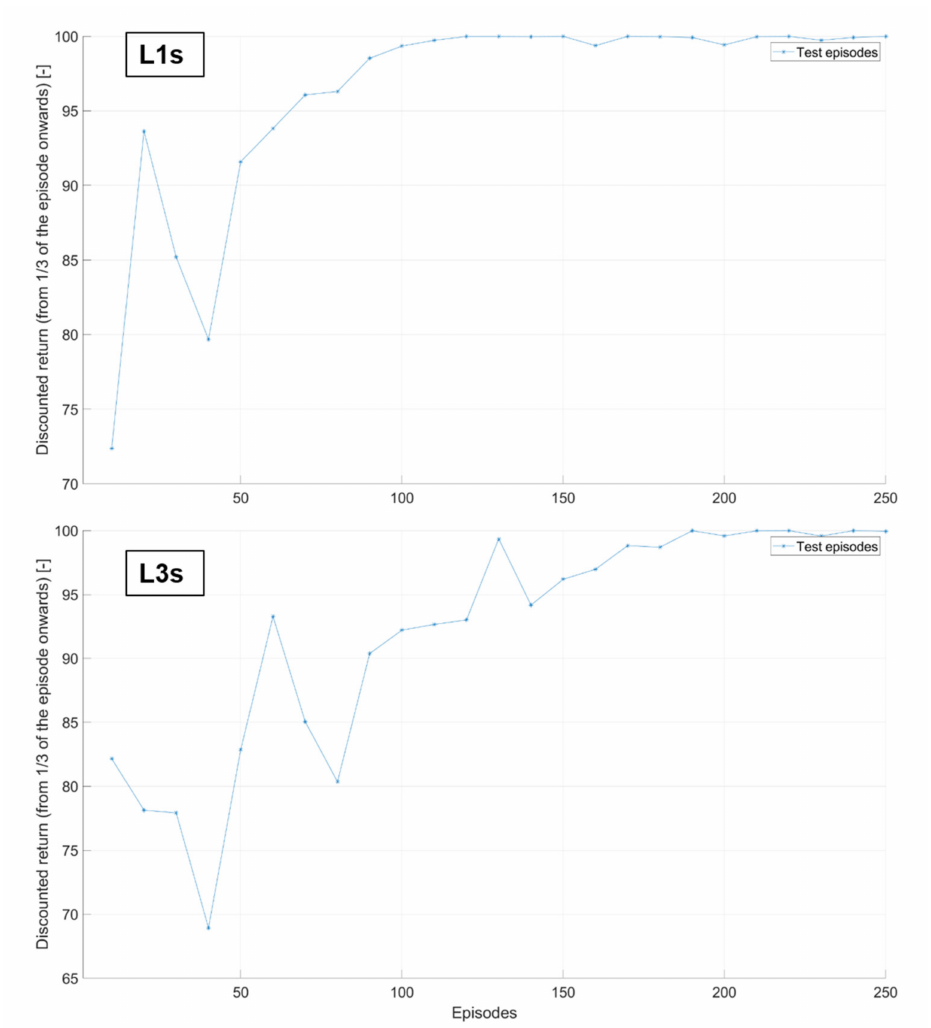
Figure 18. Comparison of the discounted return evaluated at 1/3 of the testing episodes for L1s and L3s.